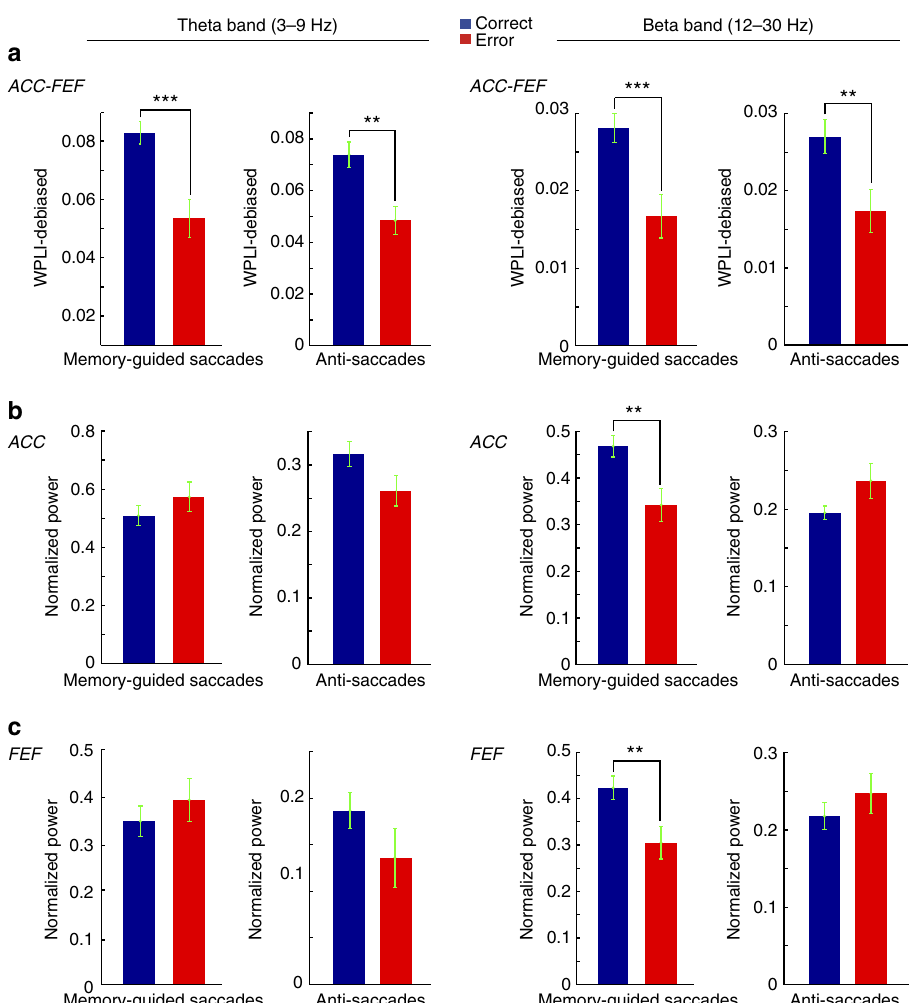
Figure 4 | Correct task performance is dependent on field-field coherence but not on LFP power. ( a ) Shown are the comparison of theta- (columns 1 and 2) and beta-band (columns 3 and 4) WPLI-debiased coherence between correct and error memory-guided saccades in the delay period of the memory-guided saccade task (400–1,100ms following target stimulus onset) and the preparatory period (400–1,100ms following fixation onset) of the anti-saccade task. ( b ) Same as in a , but show normalized ACC theta- and beta-band power. ( c ) Same as in a but for normalized FEF power. * P o 0.05; ** P o 0.01; *** P o 0.001, t -test. Error bars indicate